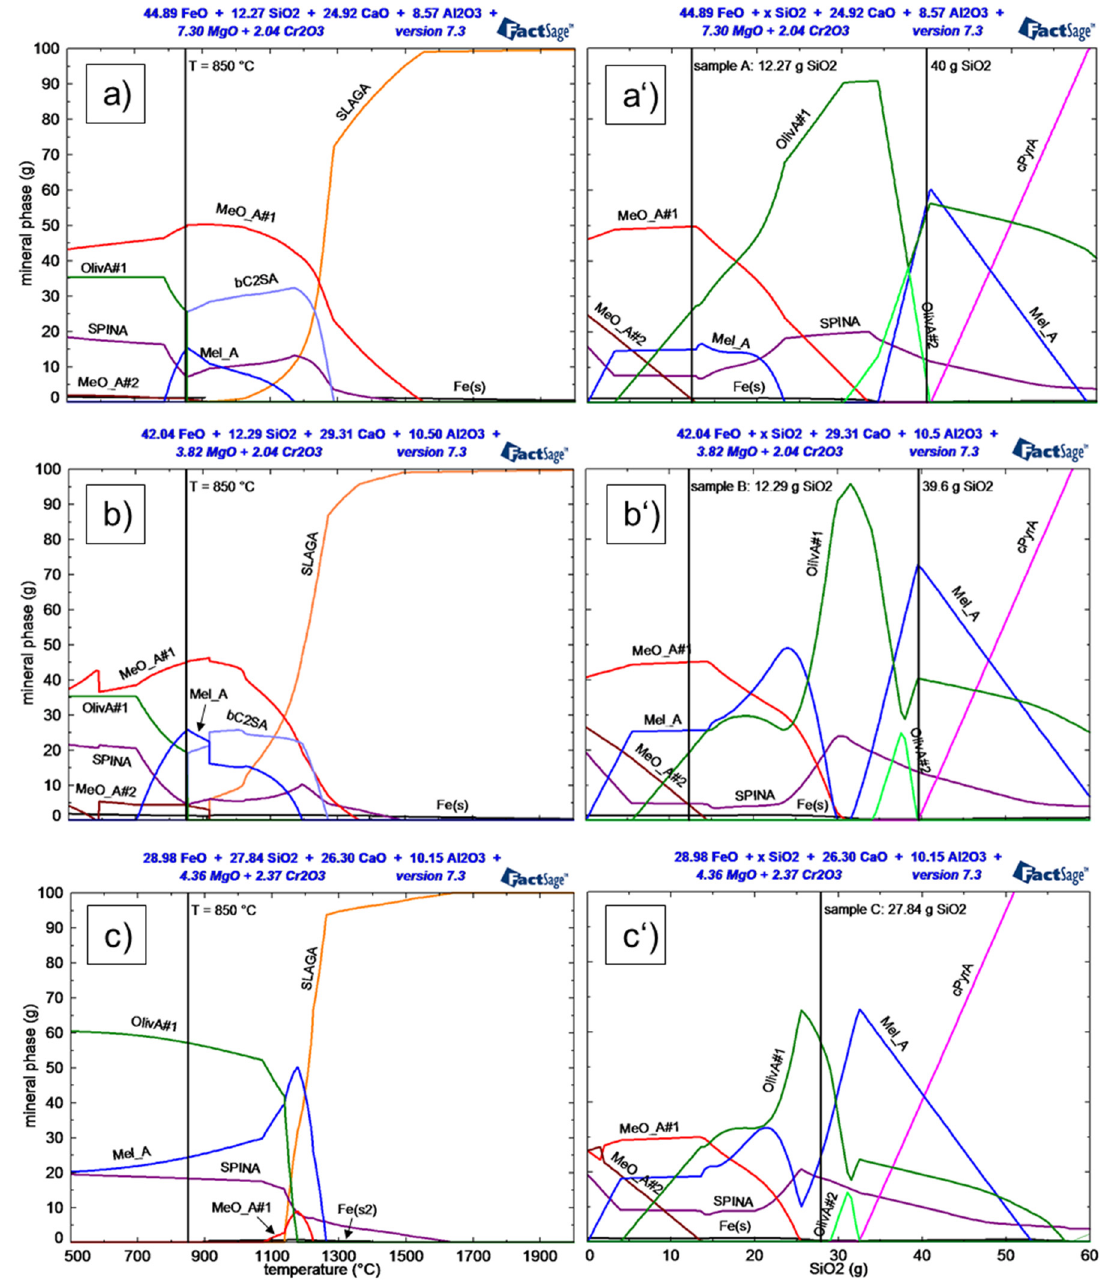
Figure 1. FactSage TM calculations. ( a ) and ( a’ ) sample A, ( b ) and ( b’ ) sample B and ( c ) and ( c’ ) sample C. ( a – c ) Mineral phase composition as a function of temperature. ( a’ – c’ ) Mineral phase composition at 850 °C with varying SiO 2 content (not normalized); the normalized SiO 2 concentration of samples A–C as well as the target SiO 2 concentrations for samples A and B are marked. Abbreviations according to FactSage TM : liquid slag (SLAGA), olivine group (OlivA), melilite group (Mel_A), wuestite solid solution (MeO_A), spinel solid solution (SPINA), clinopyroxene (cPyrA), larnite (bC2SA), and Fe(bcc) (Fe(s)). Plotted for publication with version 7.3 (FToxid, 2019 and FactPS, 2019) and calculated as described in Section 2.2.